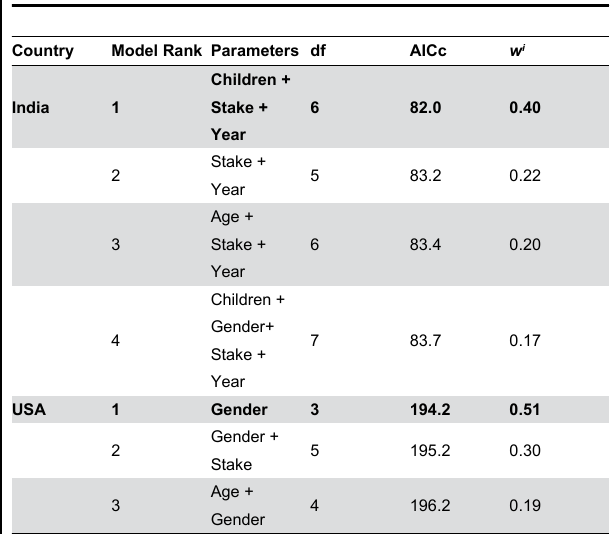
Table 2. The top models (models within 2AICc units of the best model), with AICc values and Akaike weights ( w i